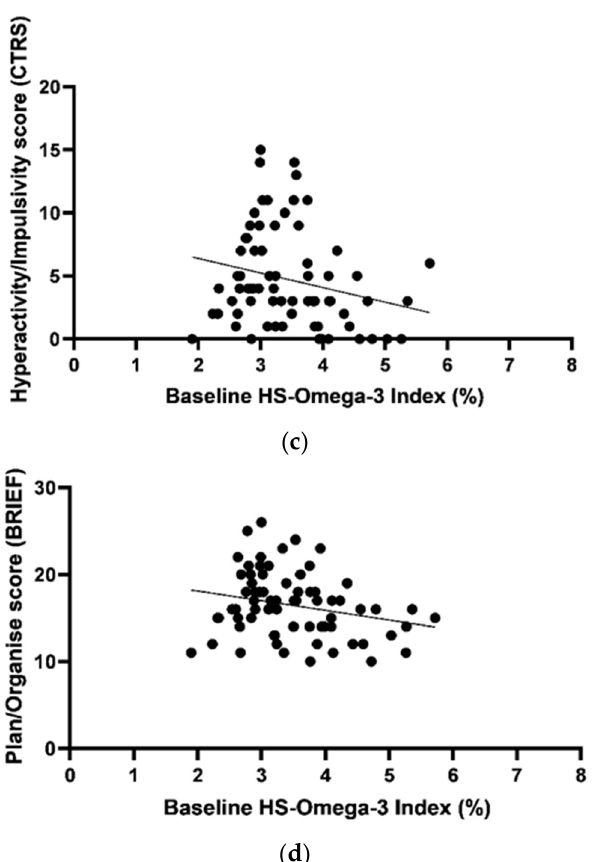
Figure 3. Correlations between the HS-Omega-3 Index ® (%) and Behavioural Self-Regulation from the CSBQ (r = 0.287, p = 0.015) ( a ), Cognitive Self-Regulation from the CSBQ (r = 0.242, p = 0.042) ( b ), Hyperactivity/Impulsivity scale from the CTRS (r = − 0.250, p = 0.037) ( c ), Plan/Organise raw score from the BRIEF (r = − 0.225, p = 0.061) ( d ) determined by Spearman correlation.